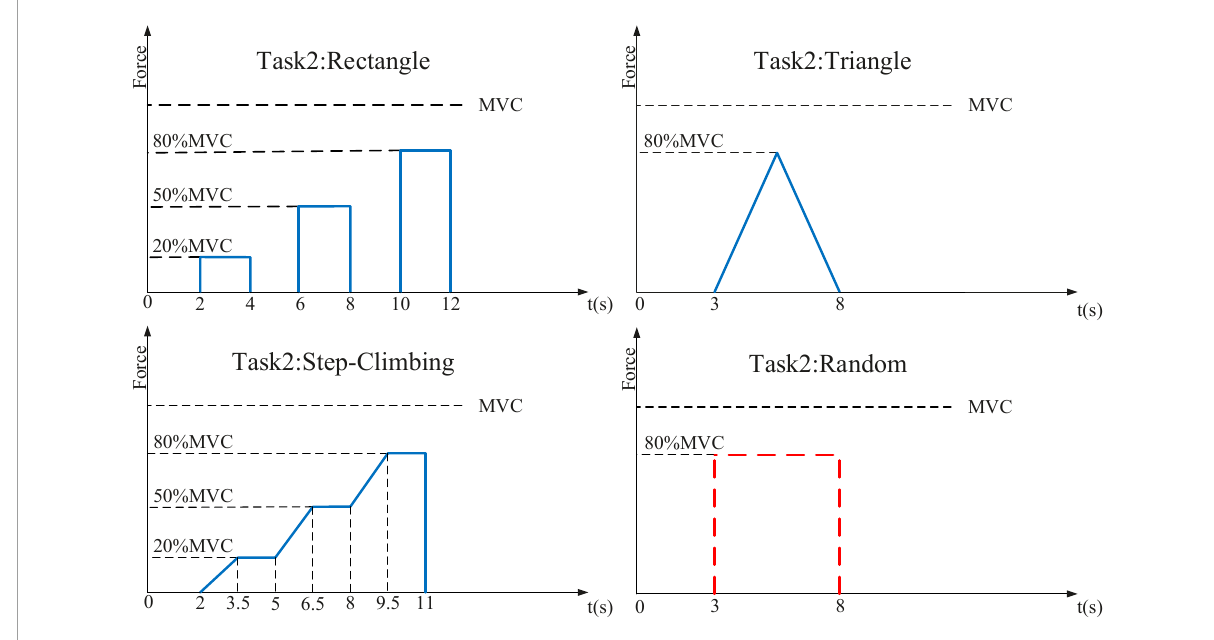
FIGURE4 Four profiles to apply force in the second experiment. Blue lines represent the target profile. In the random profile, the red dotted line represents that the subject should not exert force beyond this range.